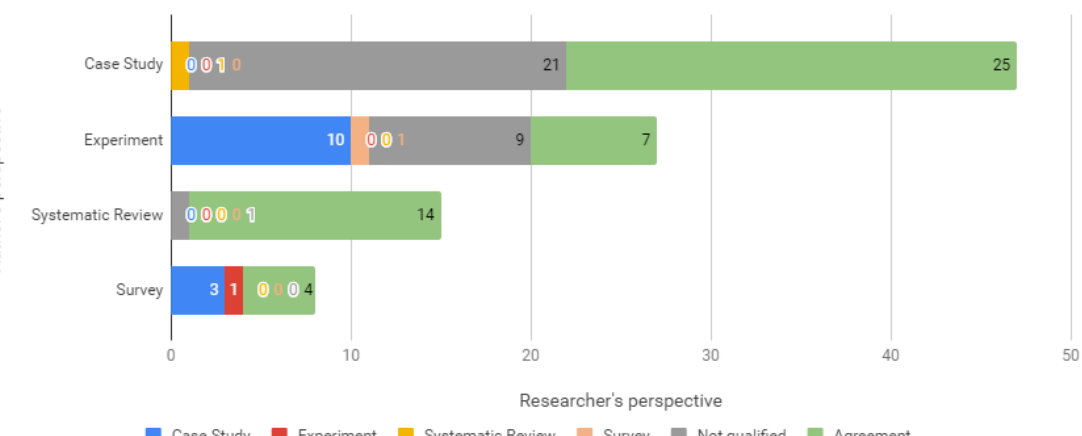
Figure 11. Types of studies included in the sample.